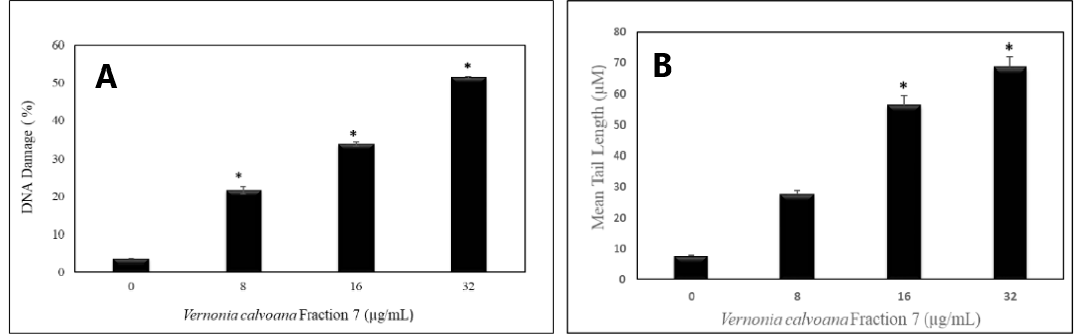
Figure 7. Vernonia calvoana fraction 7-induced DNA damage in OVCAR3 cells was measured by the comet assay. The OVCAR-3 cells were treated with different doses of VC F7 for 48 hours. ( A ) represents the percentage of DNA cleavage and ( B ) represents the comet tail length. * p < 0.05 considered significant.